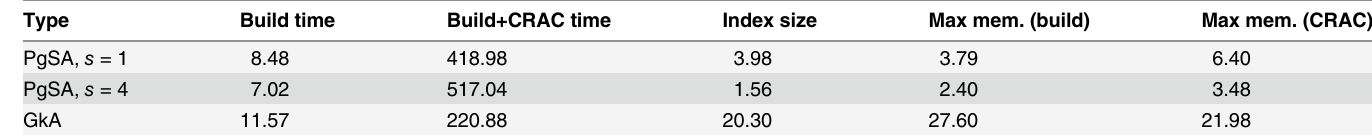
Table 7. CRAC, k = 22, on the dataset GRCh37. Times in minutes, sizes in gigabytes.